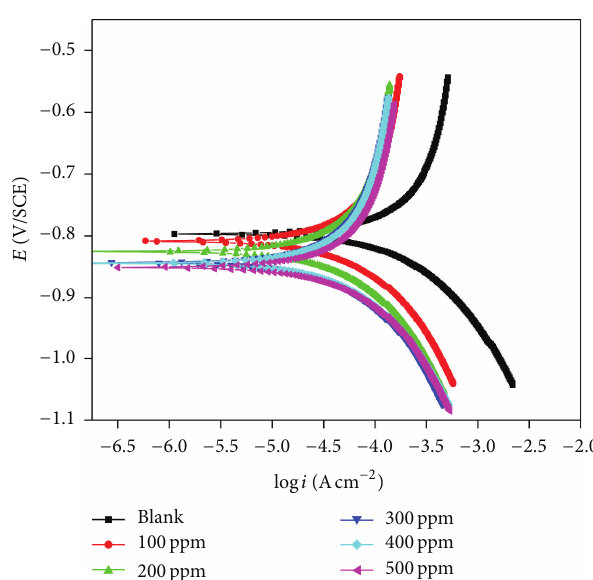
Figure 1: FTIR spectrum of GIE.